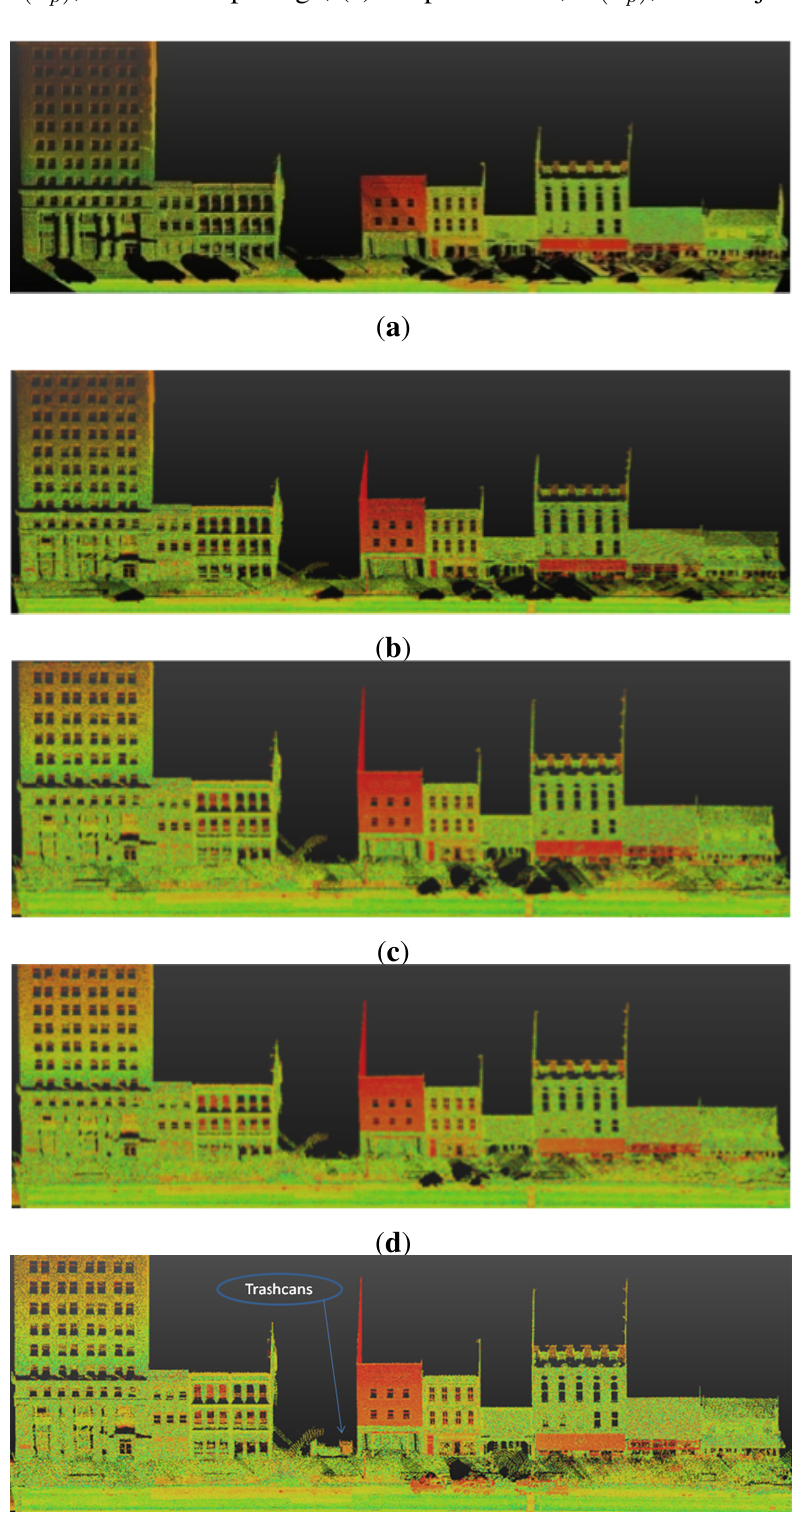
Figure 13. ( a ) shows the initial point cloud related to urban cartography full of imperfections. In ( b ), ( c ) and ( d ), completion of occluded and missing features in the urban cartography, by incremental updating, using the default sequential update function as a change of type-1 is detected. ( e ) shows the point cloud after the object update function; certain parts of the roadside and building walls along are added to the 3D cartography after ) , after first passage; (b) 3D point repetition in subsequent passages. (a) 3D point cloud, P ( n p ) , after second passage; (c) 3D point cloud, P ( n ) , after third passage; (d) 3D cloud, P ( n p p ) , after fourth passage; (e) 3D point cloud, P ( n ) , after object point cloud, P ( n p p